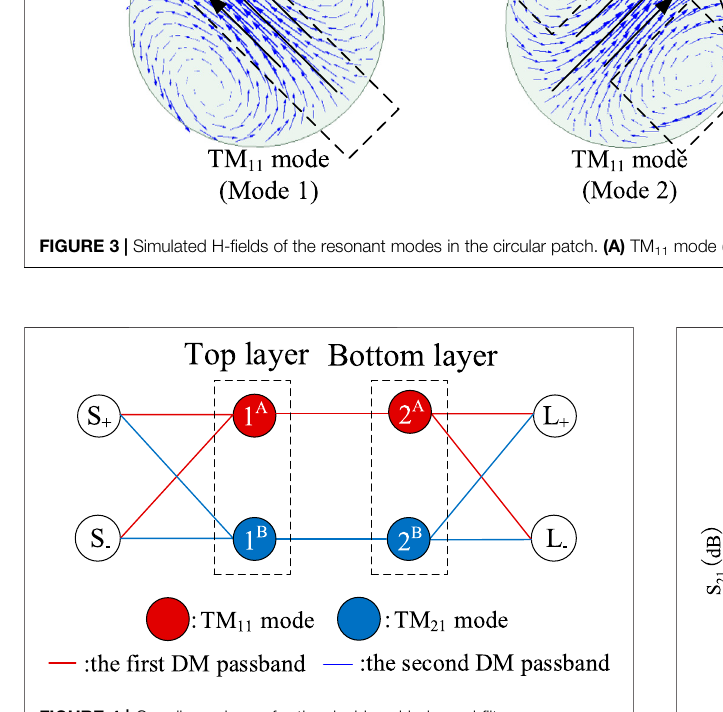
FIGURE 4 | Coupling scheme for the dual-band balanced fi lter.